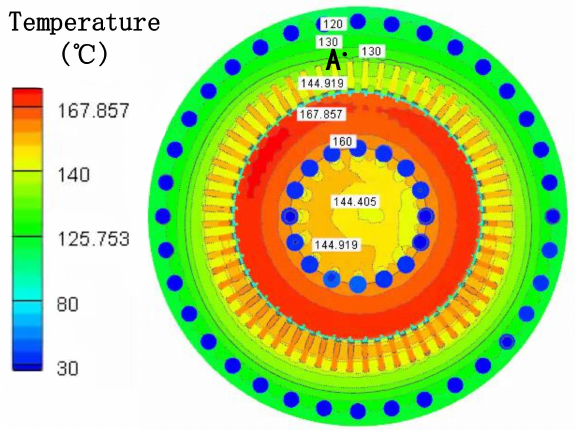
Figure 5. Temperature distribution in the radial section of the original ventilation